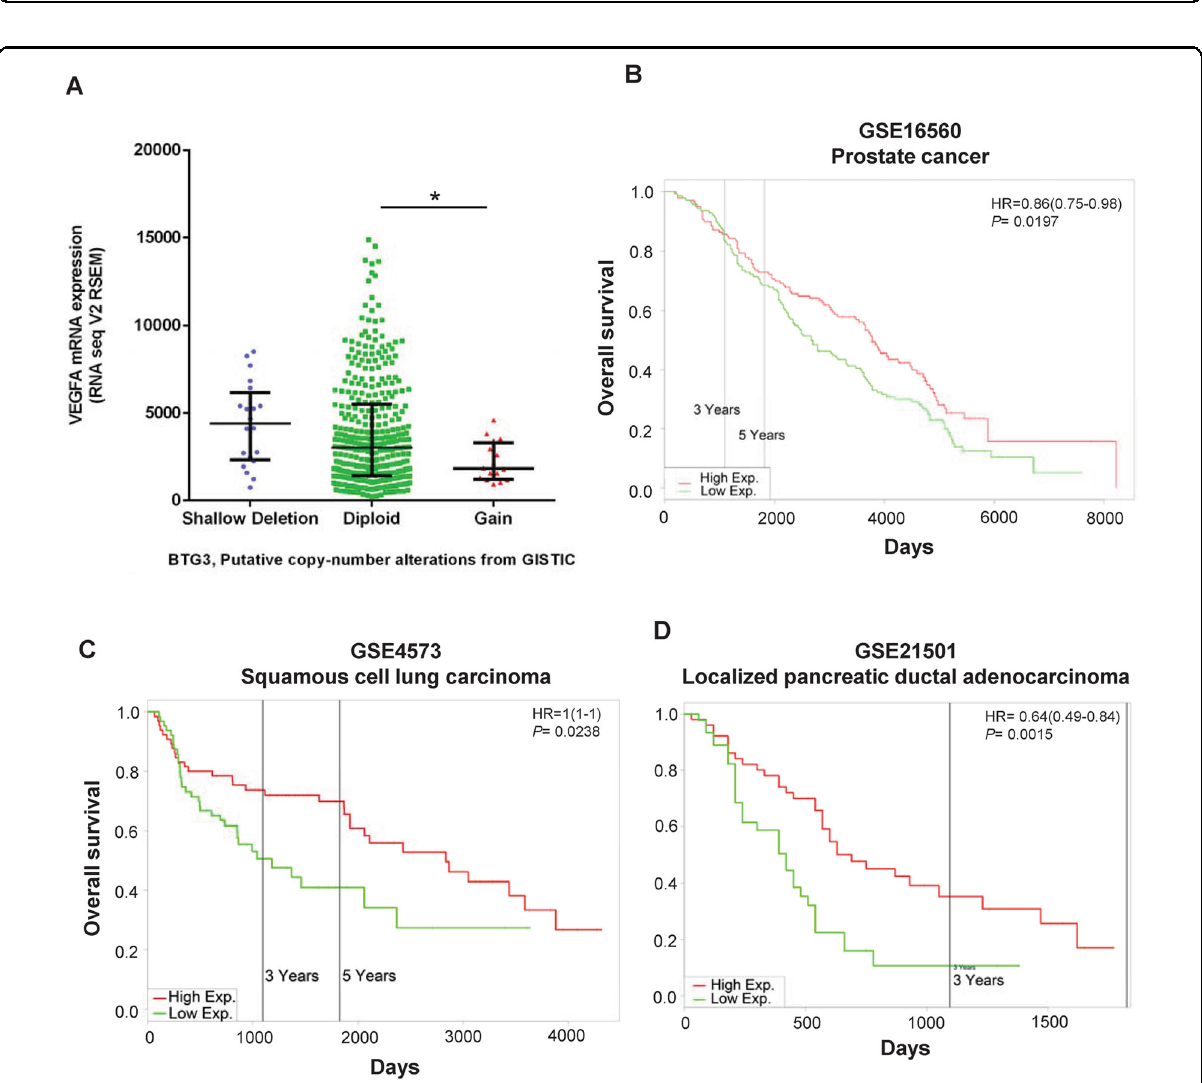
Fig. 7 Ratios of BTG3 / VEGFA expression are associated with patient survival in human cancers. a Copy number of the BTG3 gene correlates inversely with levels of VEGFA expression in prostate cancer. The relationship between BTG3 copy number and VEGFA mRNA expression was analyzed using cBioPortal for Cancer Genomics (http://www.cbioportal.org/) with data from TCGA for prostate cancer. Statistical analysis using one-way ANOVA shows marginal signi fi cance ( P = 0.0703) among the three groups. The difference between diploid and copy number gain is signi fi cant when compared by unpaired t test ( P = 0.035). b – d Low BTG3 / VEGFA expression ratio predicts poor patient survival in prostate cancer ( b ), squamous cell lung carcinoma ( c ), and localized pancreatic ductal adenocarcinoma ( d ). GSE16560 39 , GSE4573 40 , and GSE21501 41 were analyzed for their Kaplan – Meier overall survival in relation to the expression ratio of BTG3 / VEGFA . The analysis was performed using the PROGgeneV2 platform (http://